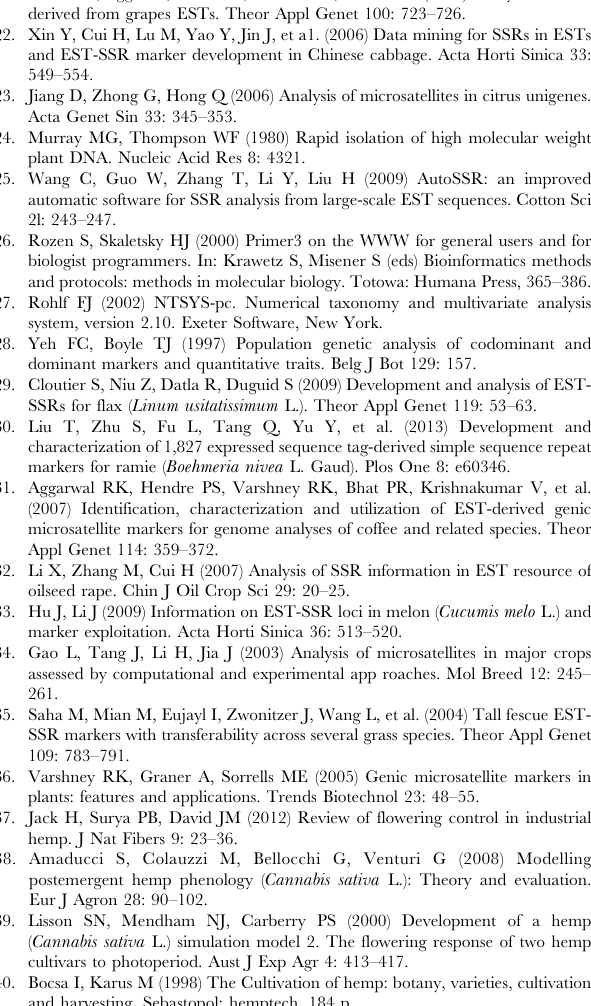
Table S4 The polymorphic ratios among 115 cannabis